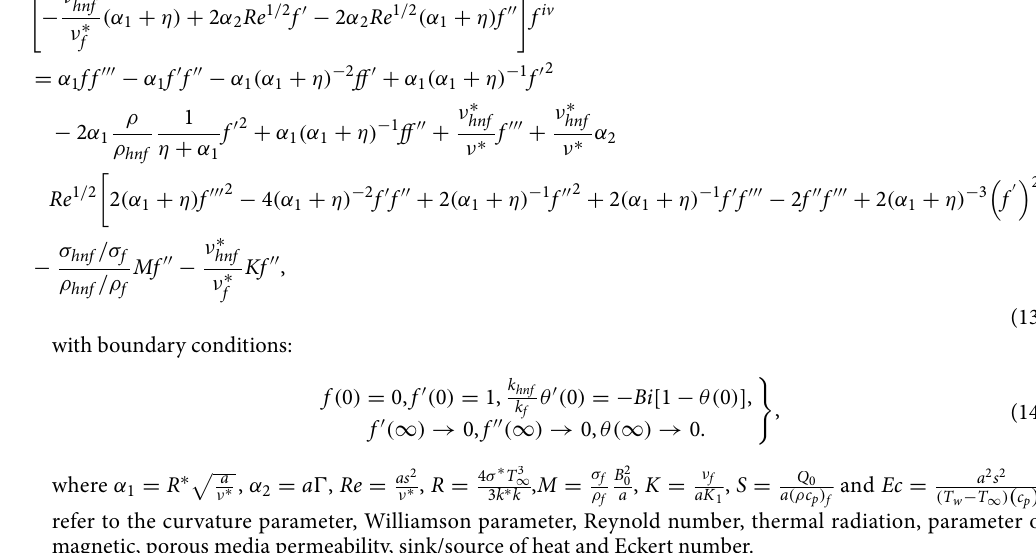
refer to the curvature parameter, Williamson parameter, Reynold number, thermal radiation, parameter of magnetic, porous media permeability, sink/source of heat and Eckert number. Coefficient of skin friction ( c f ) and local Nusselt number ( Nu s ) are defined as: